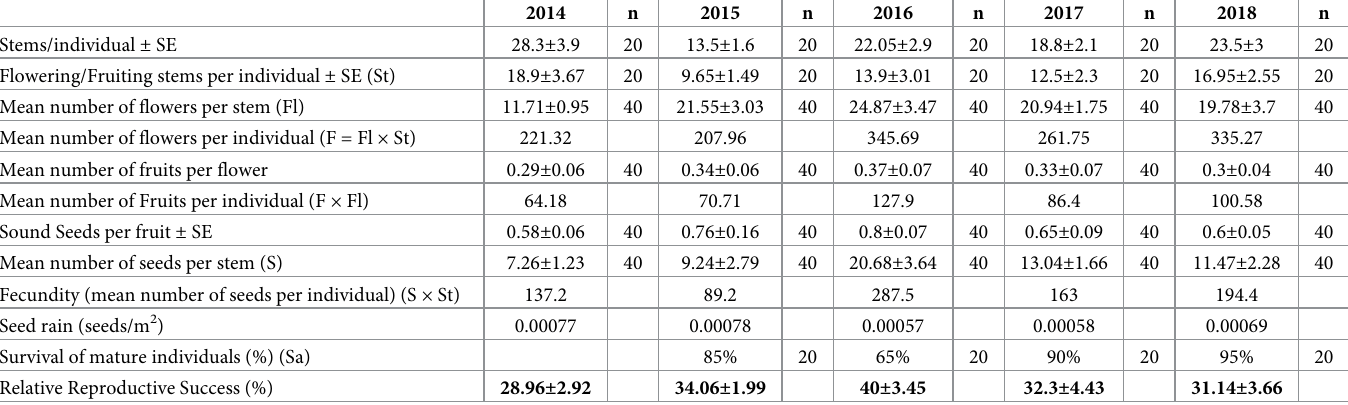
Table 3. Characteristics of reproductive biology and fecundity (expressed as mean number of seeds produced per individual) of A . naufraga in subpopulations An- Pl, An-PV and An-N during five consecutive years